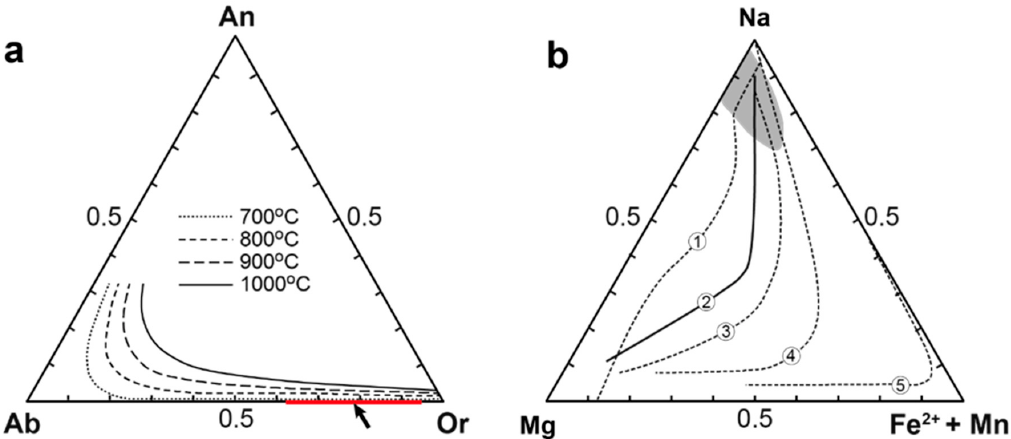
Figure 19. Compositions of felfspars and clinopyroxens from rocks of the Alluaiv site: ( a )—total range of reintegrated feldspar compositions (red line) plotted on the temperature-dependent feldspar solvus, modified after [48] (from meso- and melanocratic rocks). ( b )—total range of magmatic clinopyroxene compositions (gray field, generalized from Figure 11a). 1–5—clinopyroxene trends from other alkaline suites are shown for comparison: (1) Murun, Siberia [49], (2) Lovozero, Kola Peninsula [50], (3) Uganda [51], (4) South Qoroq [52], (5) Ilímaussaq [53].